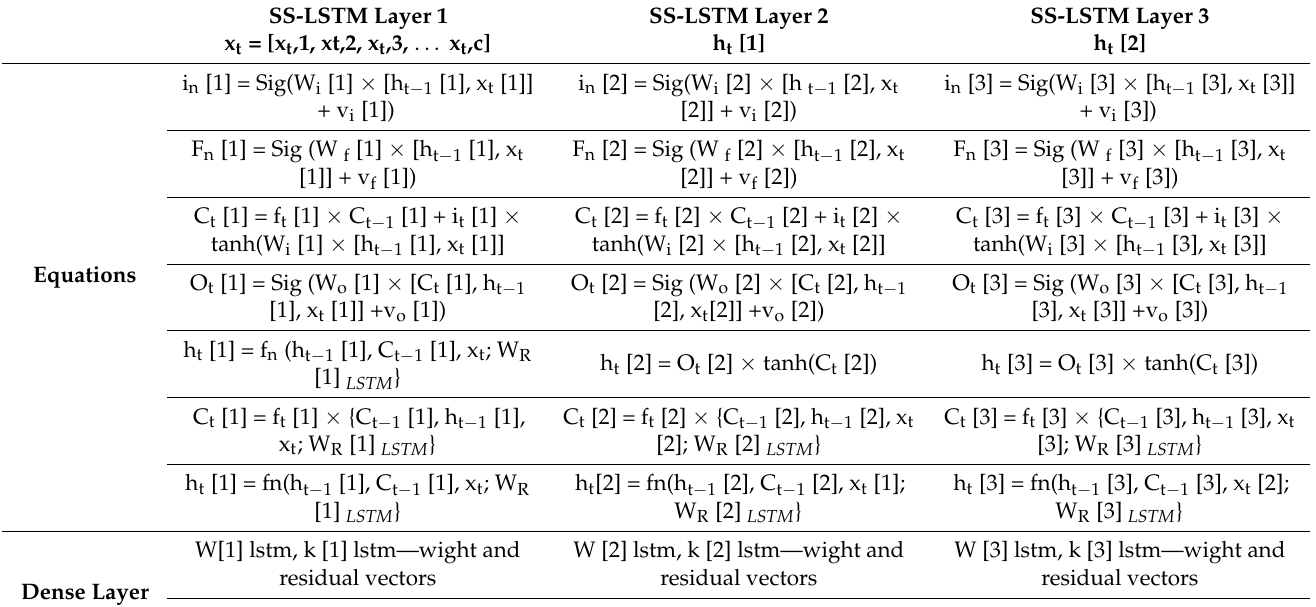
Table 1. LSTM Stacking with three different layers and its equations with the dense